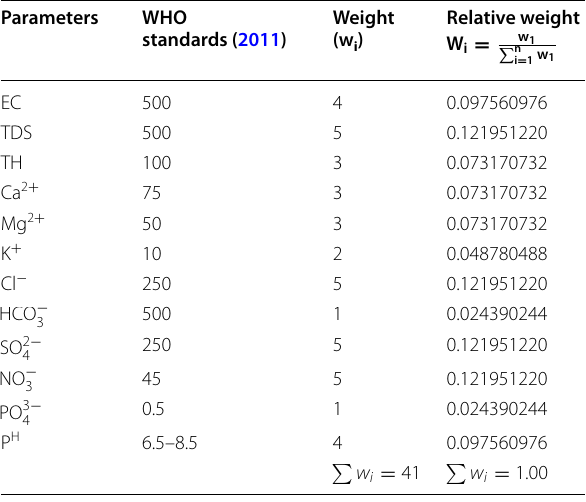
Table 1 Relative weight of some physicochemical